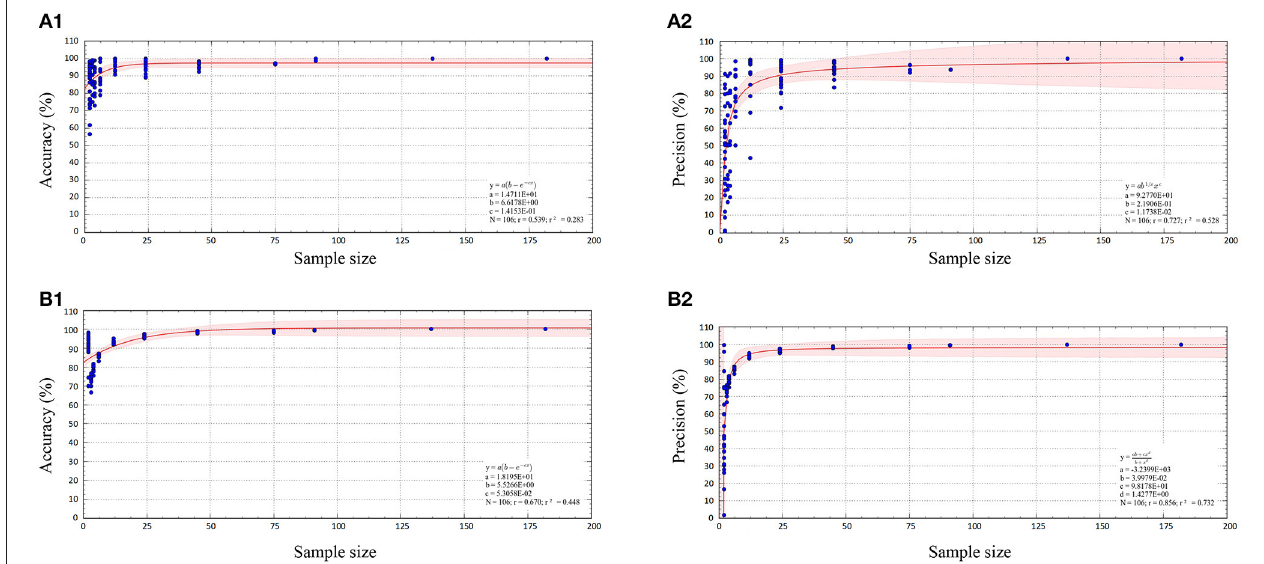
FIGURE 2 | Trends in the accuracy (1) and the precision (2) of (A) the amount of total wild meat and (B) the price of wild meat in relation to the results obtained with the maximum sampling effort in two 12-month surveys conducted in 2006–2007 and 2017–2018.